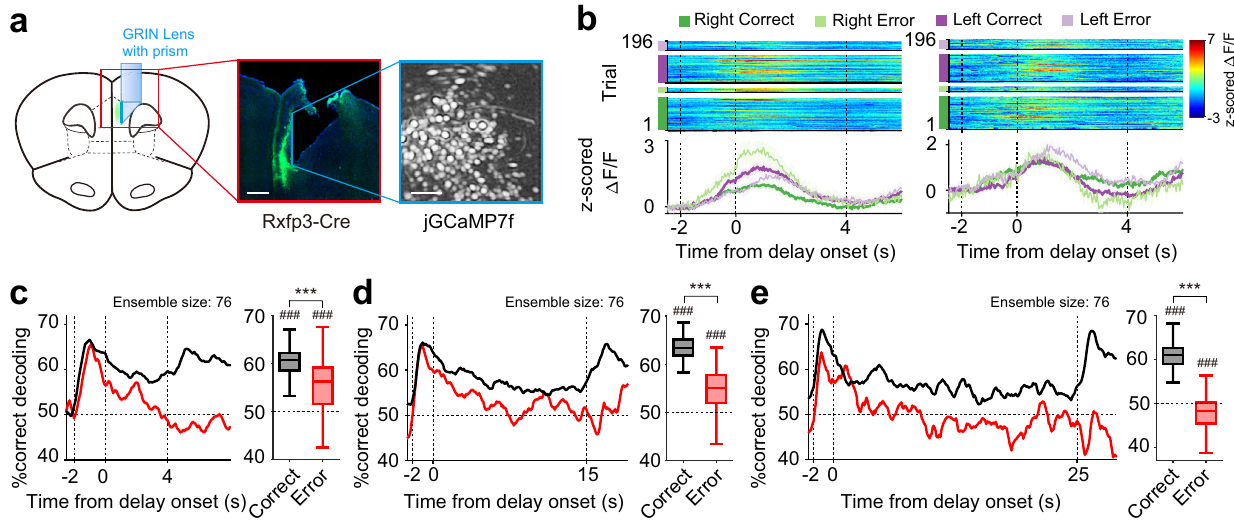
Fig. 10 Activity of IT neurons during extended delay periods. a Schematic (left) and a coronal brain section (representative of four mice; middle) showing the GRIN prism lens position and the spread of jGCaMP7f (green) in the mPFC. Right, fi eld of view in an example session. Scale bar, left, 500 μ m, right, 100 μ m. b Example calcium responses of IT neurons during correct and error trials. The same format as in Fig. 4a except that Δ F/F traces are shown instead of spike rasters. c – e Left, results of neural decoding using calcium transient signals obtained from four Rxfp3-Cre mice (ensemble size = 76 neurons; 1-s window advanced in 0.1-s steps). Delay durations, 4, 15, and 25 s. Right, results of neural decoding using the entire delay-period activity (4, 15, or 25 s). ### p < 0.001 (difference from chance level, t -test); *** p < 0.001 (correct versus error, paired t -test). Shading, SEM across trials ( b ) and 100 decoding iterations ( c – e , left). Boxplots ( c – e , right) show median, interquartile range, and maximum and minimum within 1.5 interquartile